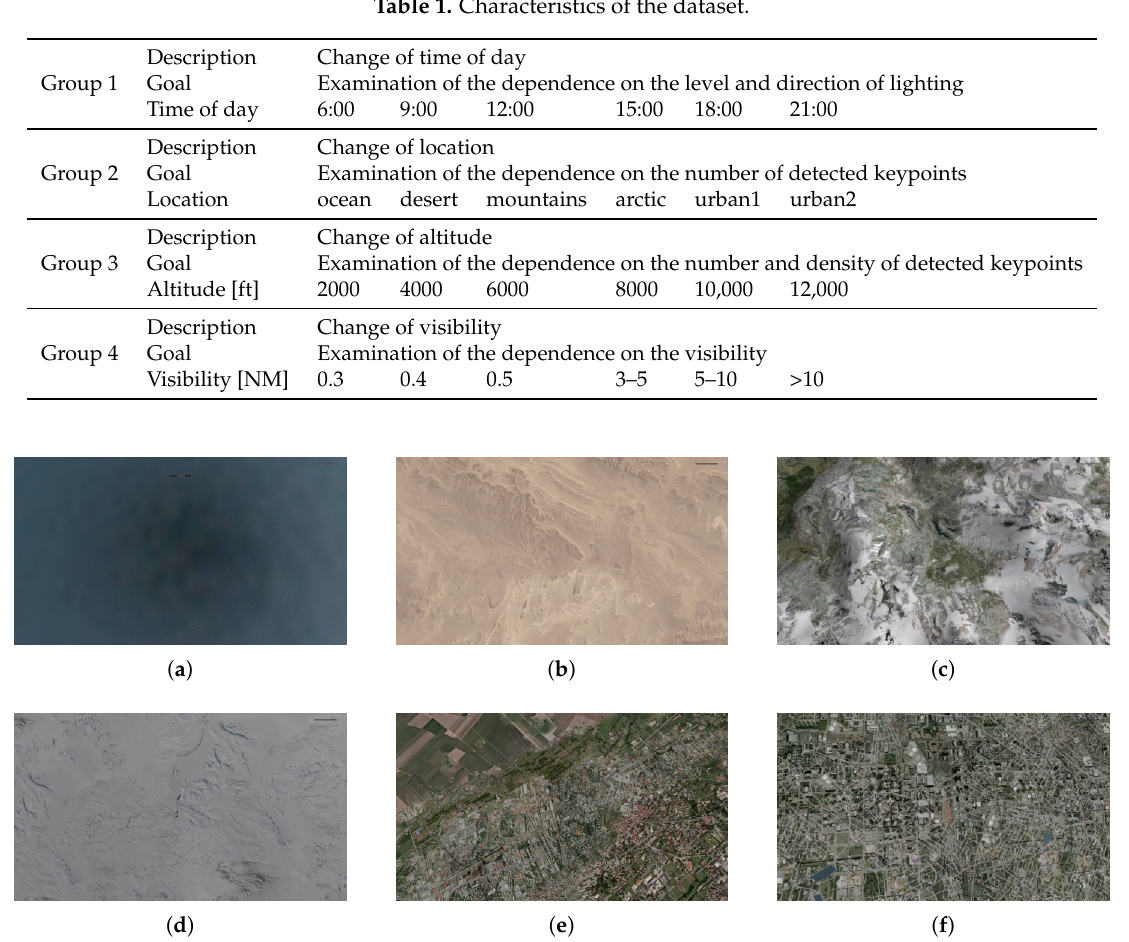
Figure 10. Selected frames from test videos in group 2: ( a ) ocean, ( b ) desert, ( c ) mountains, ( d ) arctic, ( e ) urban1, ( f ) urban2.